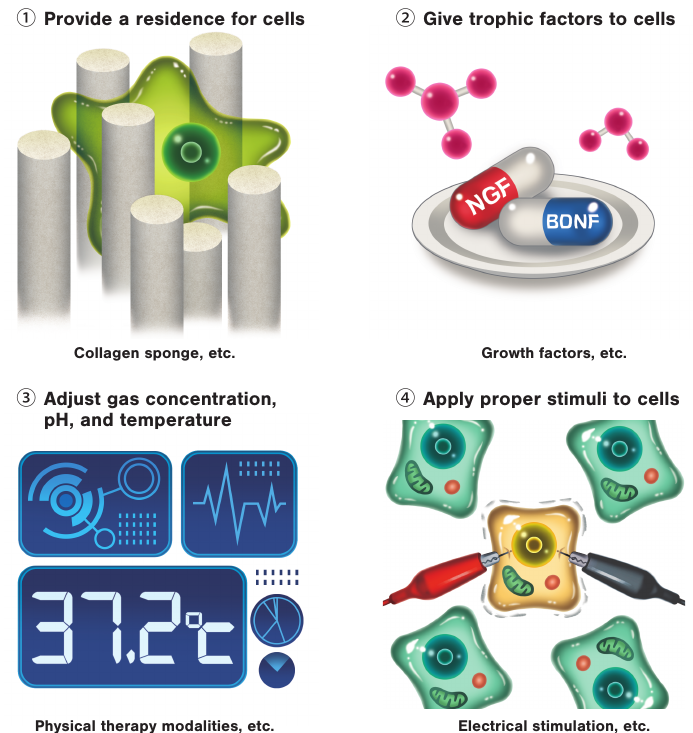
Figure 2. Adjustment of microenvironments is the key to success for cell therapy. Providing a residence for cells; providing su ffi cient nutrients; regulating gas concentration, pH, and temperature; and applying appropriate mechanical stress are considered essential for the success of cell